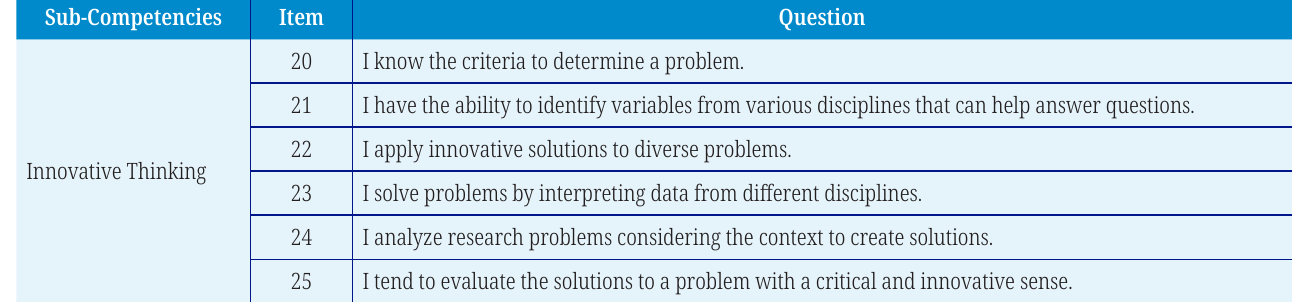
Table 2. eComplexity instrument items